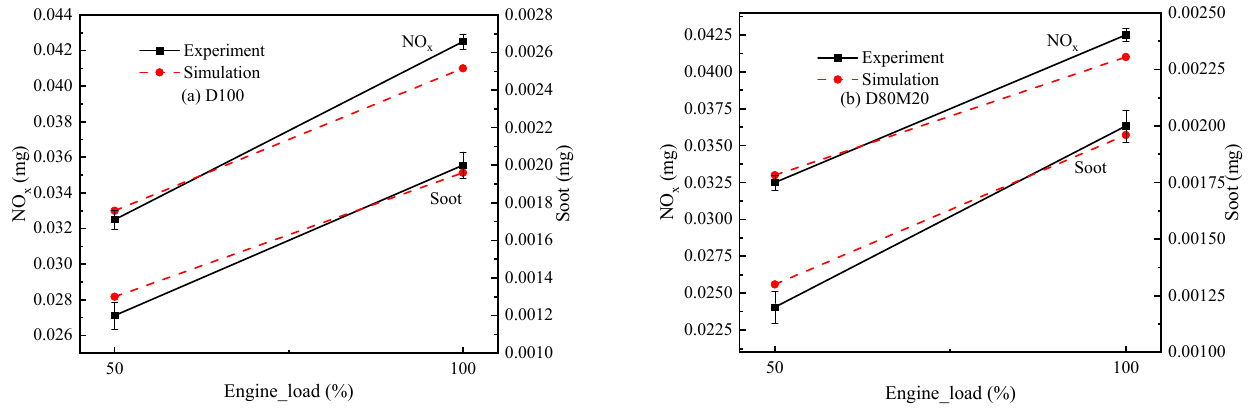
Figure 5. Engine validation results for NO x and soot emissions. ( a ) D100, ( b ) D80M20.